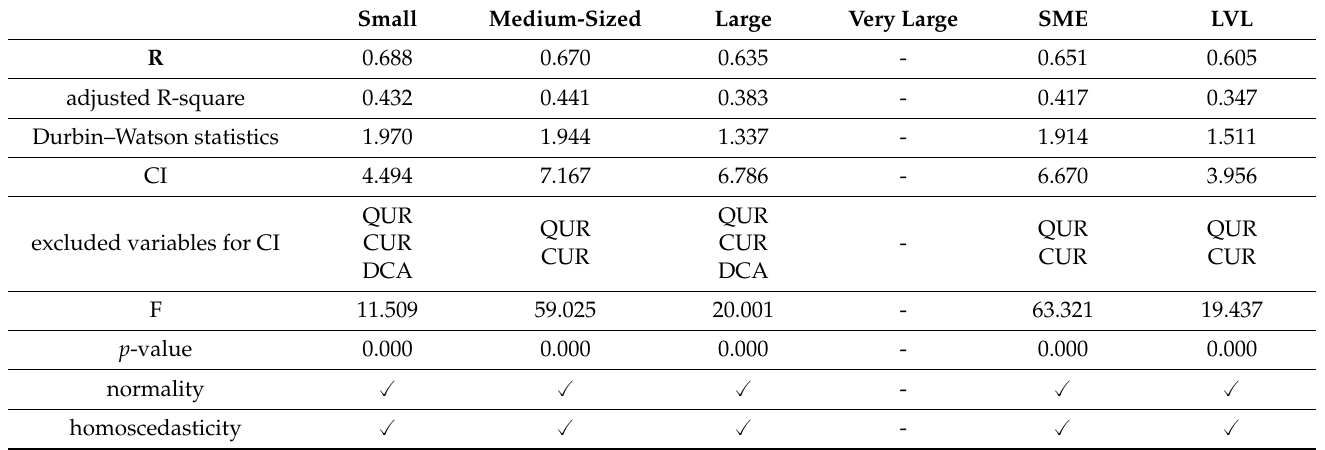
Table 12. Model summary for the transport companies in the Slovak Republic. Small Medium-Sized Large